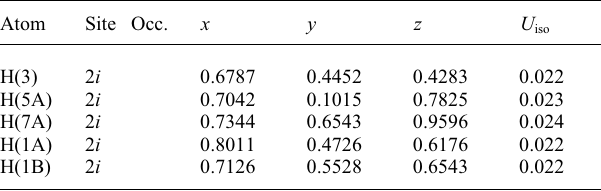
Table 2. Atomic coordinates and displacement parameters (in Å 2 )